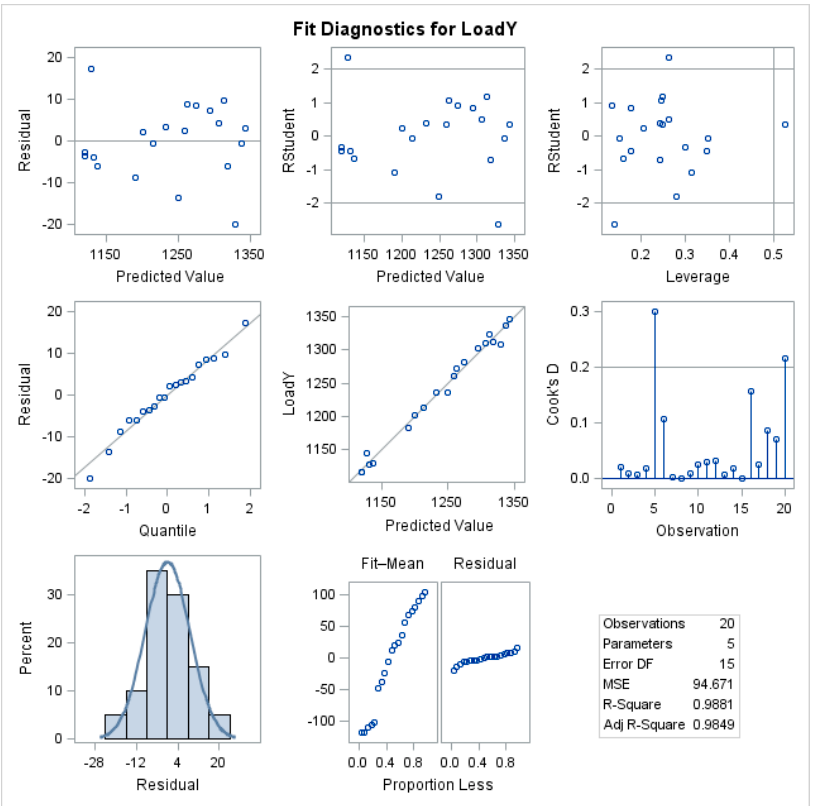
Figure A1. Residual Analysis of the Annual Regression Model. Figure A.1. Residual Analysis of the Annual Regression Model. Figure A.1. Residual Analysis of the Annual Regression Model.